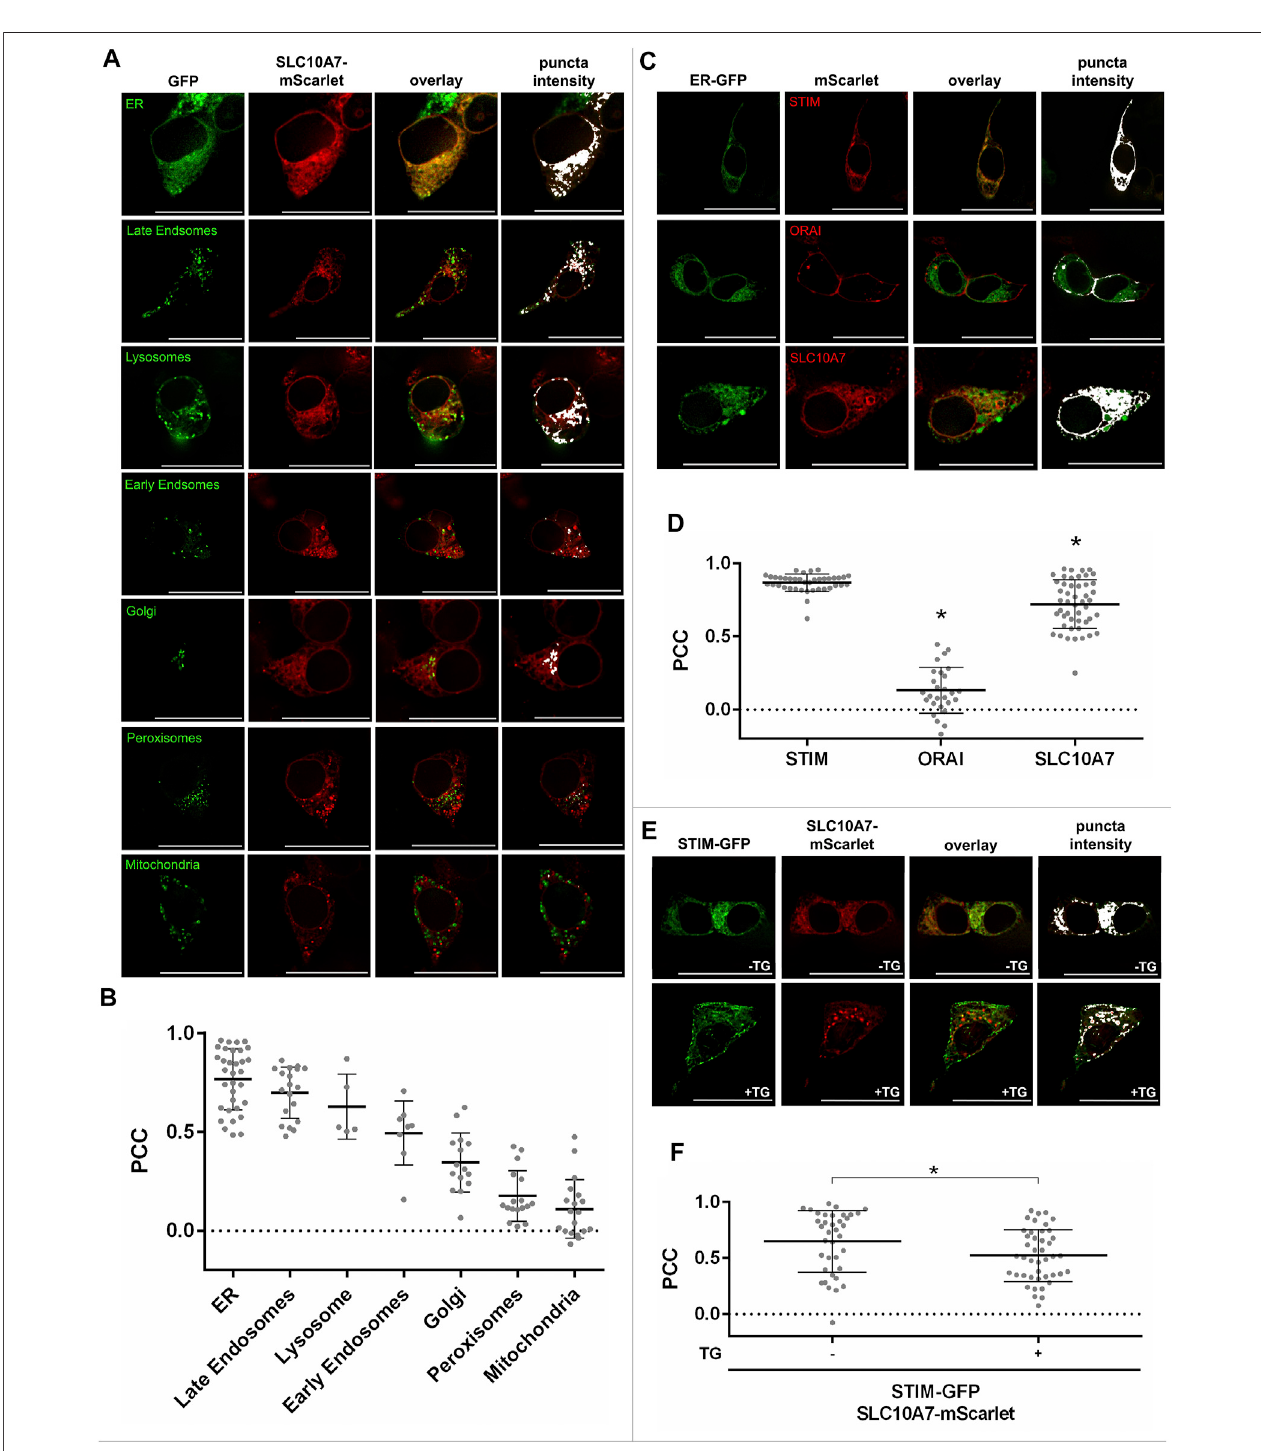
FIGURE2| Cellular localizationoftheSLC10A7/RCAS protein and itsco-localization withSTIMand ORAI. (A) Co-localization oftheSLC10A7-mScarlet construct (red fl uorescence) with the indicated organelle markers (green fl uorescence). Images represent maximum projections of Z-stacks at 630 × magni fi cation after deconvolution. (B) Graphical representation of the co- fl uorescence between SLC10A7-mScarlet and ER ( n (cid:2) 33), late endosomes ( n (cid:2) 19), lysosomes ( n (cid:2) 5), early endosomes ( n (cid:2) 8), Golgi ( n (cid:2) 15), peroxisomes( n (cid:2) 17), and mitochondria ( n (cid:2) 19), expressed as Pearson ’ s correlation coef fi cient (PCC). Each dot represents the PCC of a single cell. Numbers in brackets indicate the number of cells analyzed. (C) Co-localization of the mScarlet-tagged STIM, ORAI, and SLC10A7 constructs with theGFP-taggedERorganellemarker.ImagesrepresentmaximumprojectionsofZ-stacksat630 × magni fi cationafterdeconvolution (D) Graphicalrepresentationofthe